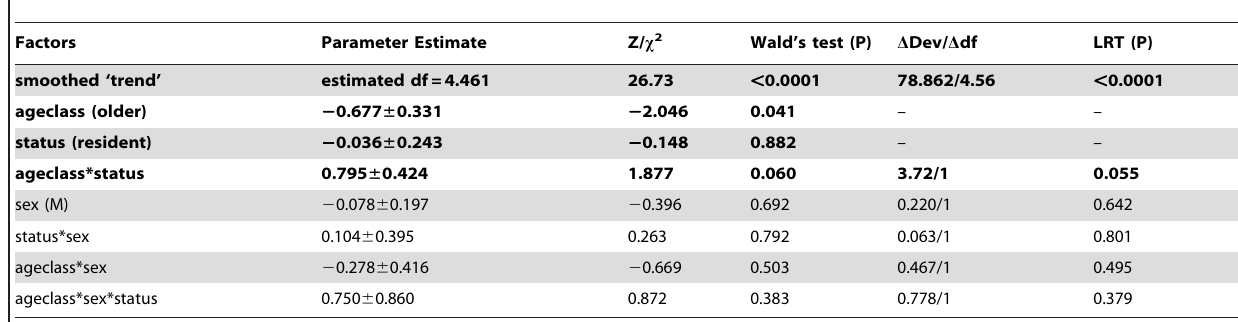
Table 5. Results of models examining the influence of temporal/demographic factors on variation in pox prevalence.